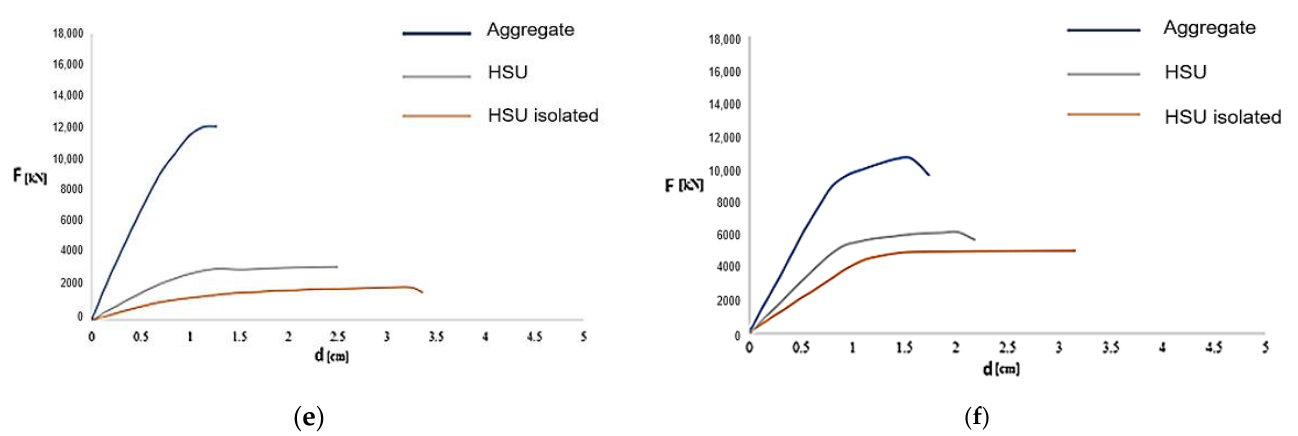
Figure 11. Pushover curves of the worst analysis scenarios for the whole aggregate ( a , b ), the heading structural units in aggregate (HSU) ( c , d ), and the isolated (HSU isolated) ( e , f ) configurations.